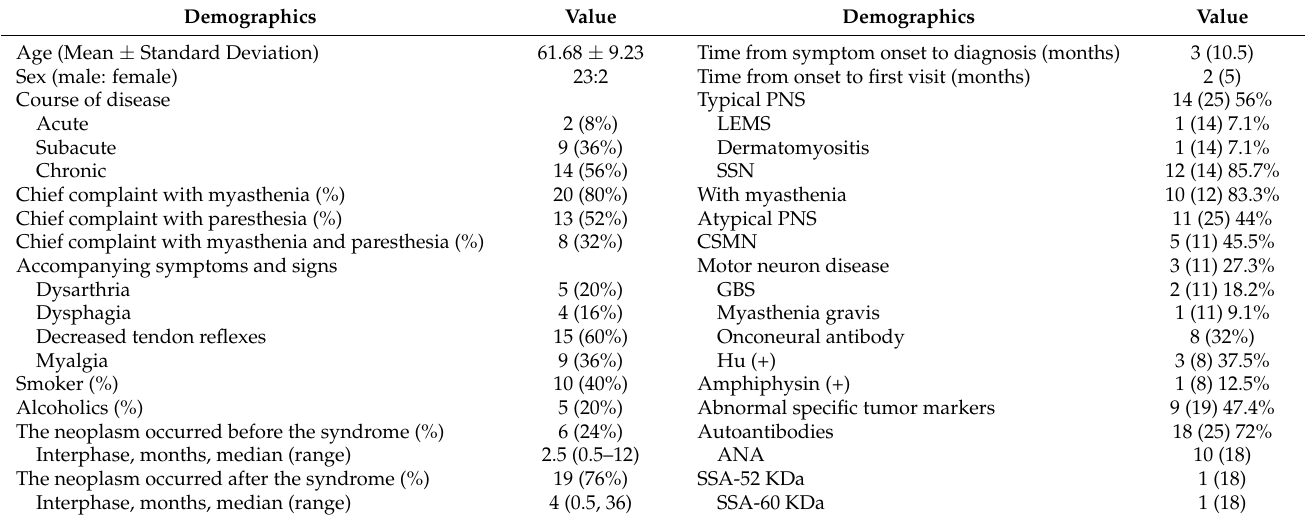
Table 1. Baseline characteristics of PNS with peripheral nerve